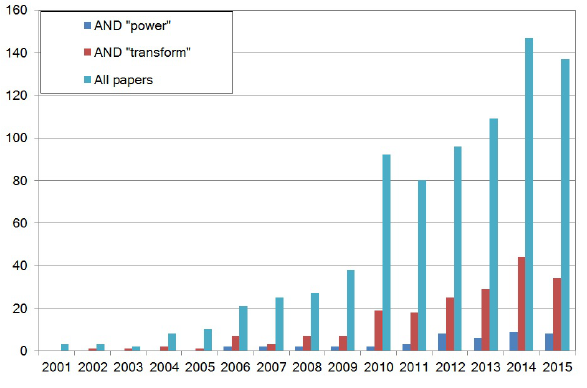
Fig. 4. Total number of papers and number of papers that also mention power and transformation,